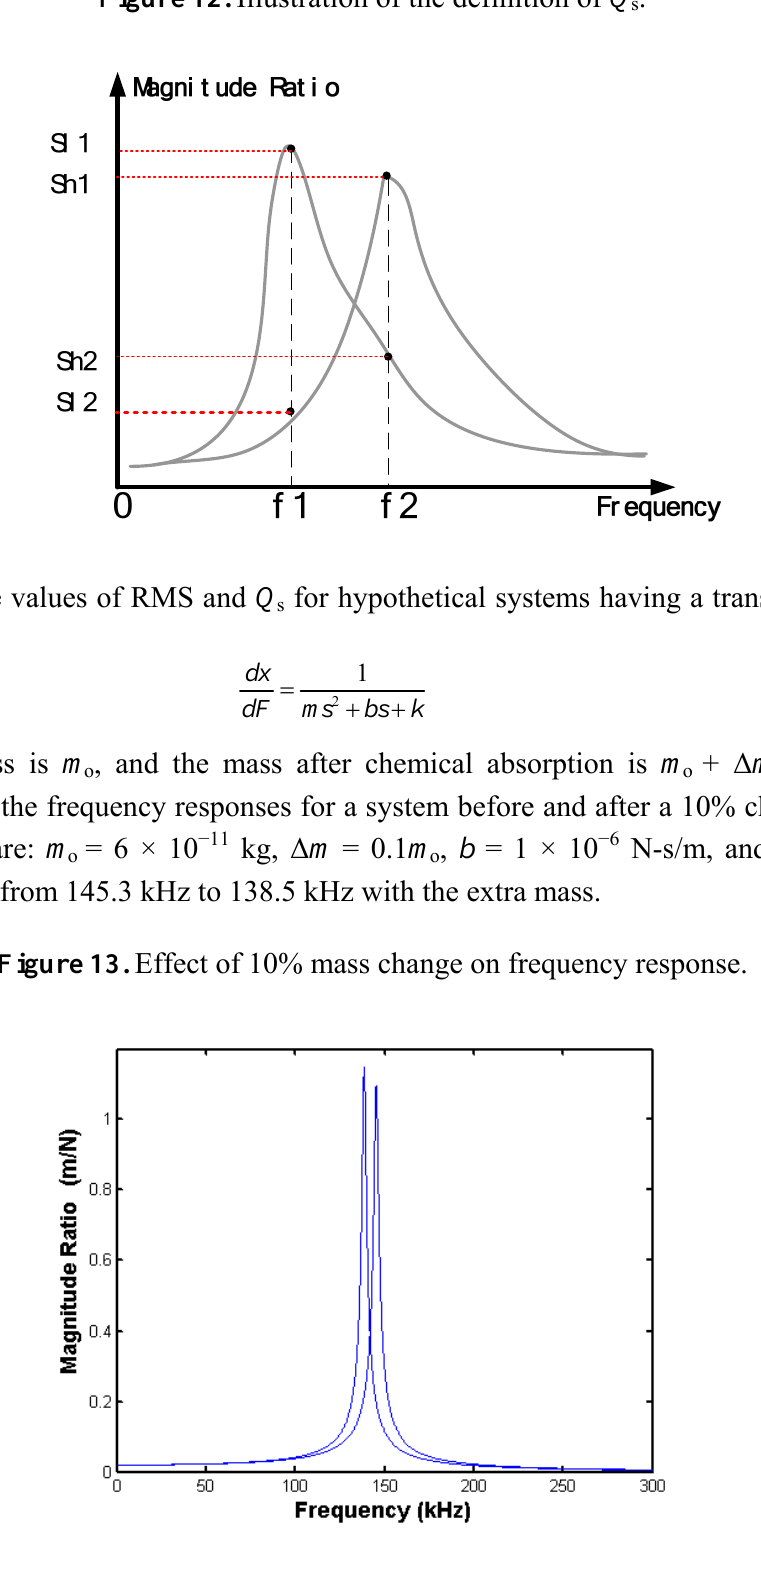
Figure 12. Illustration of the definition of Q